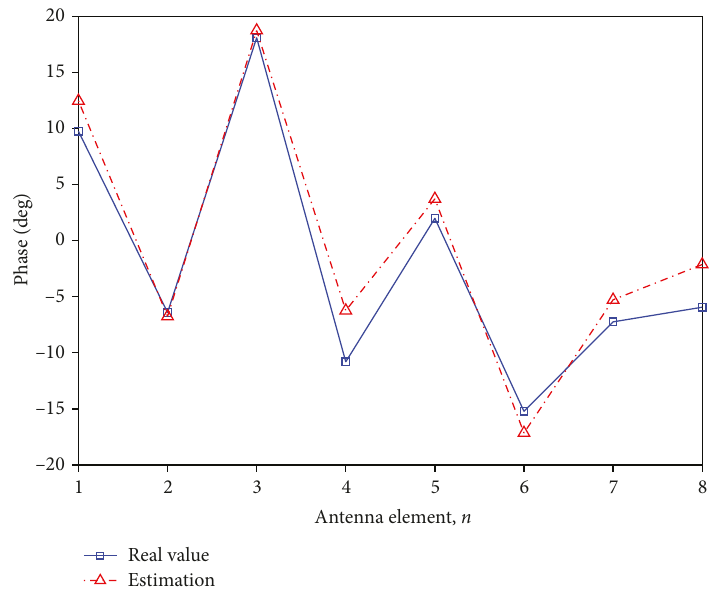
Figure 6: The array element relative phase and the corresponding estimation